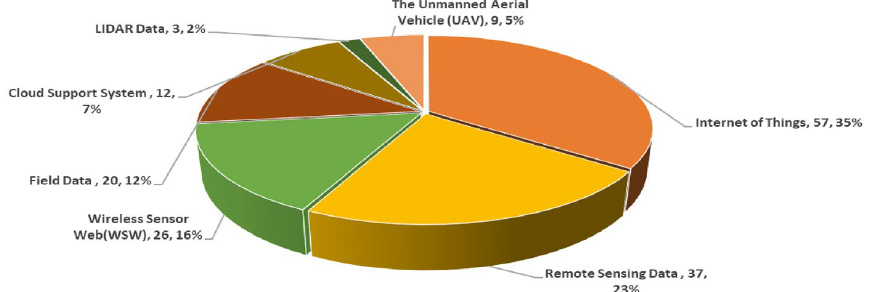
Fig. 11 The number of papers per technology